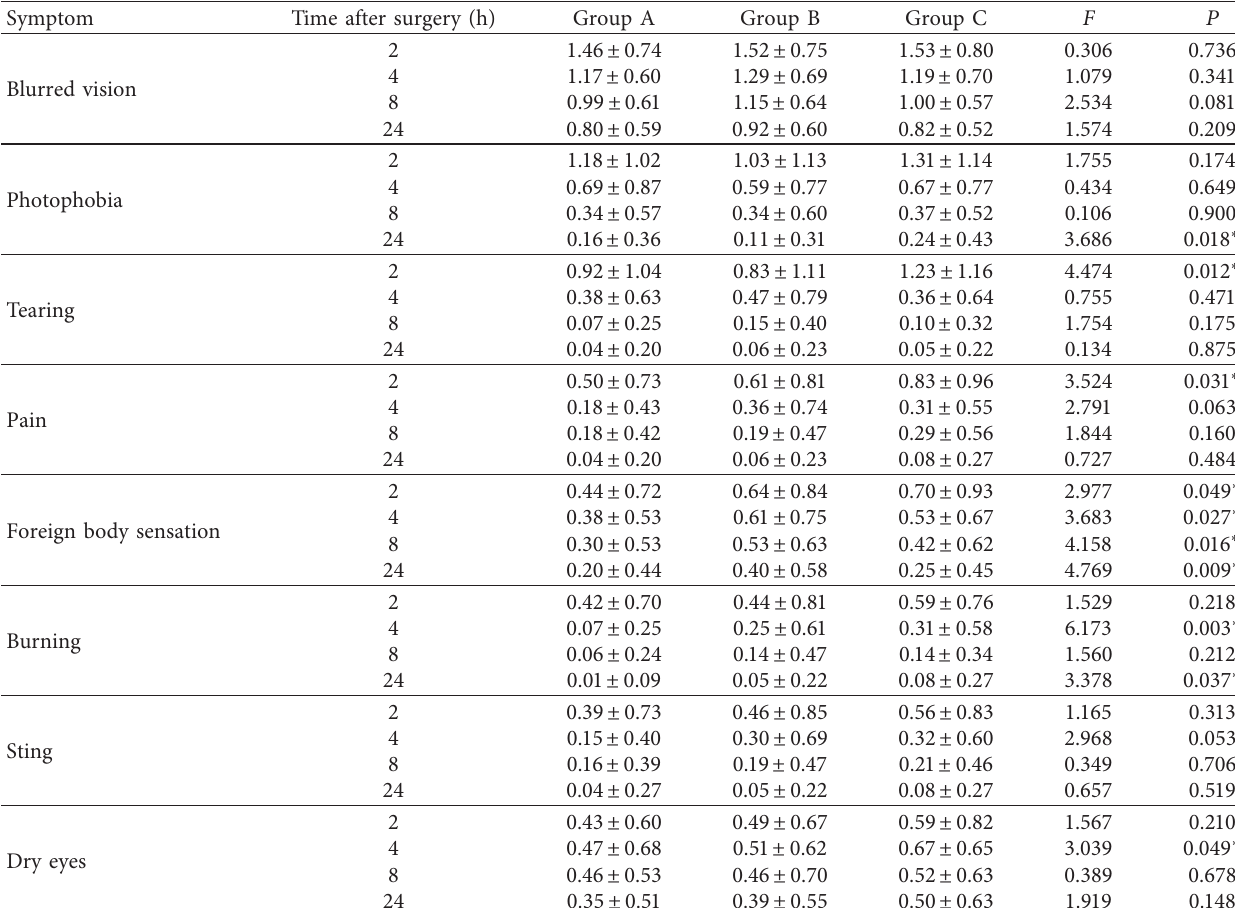
Table 3: The scores of symptoms after SMILE in all 3